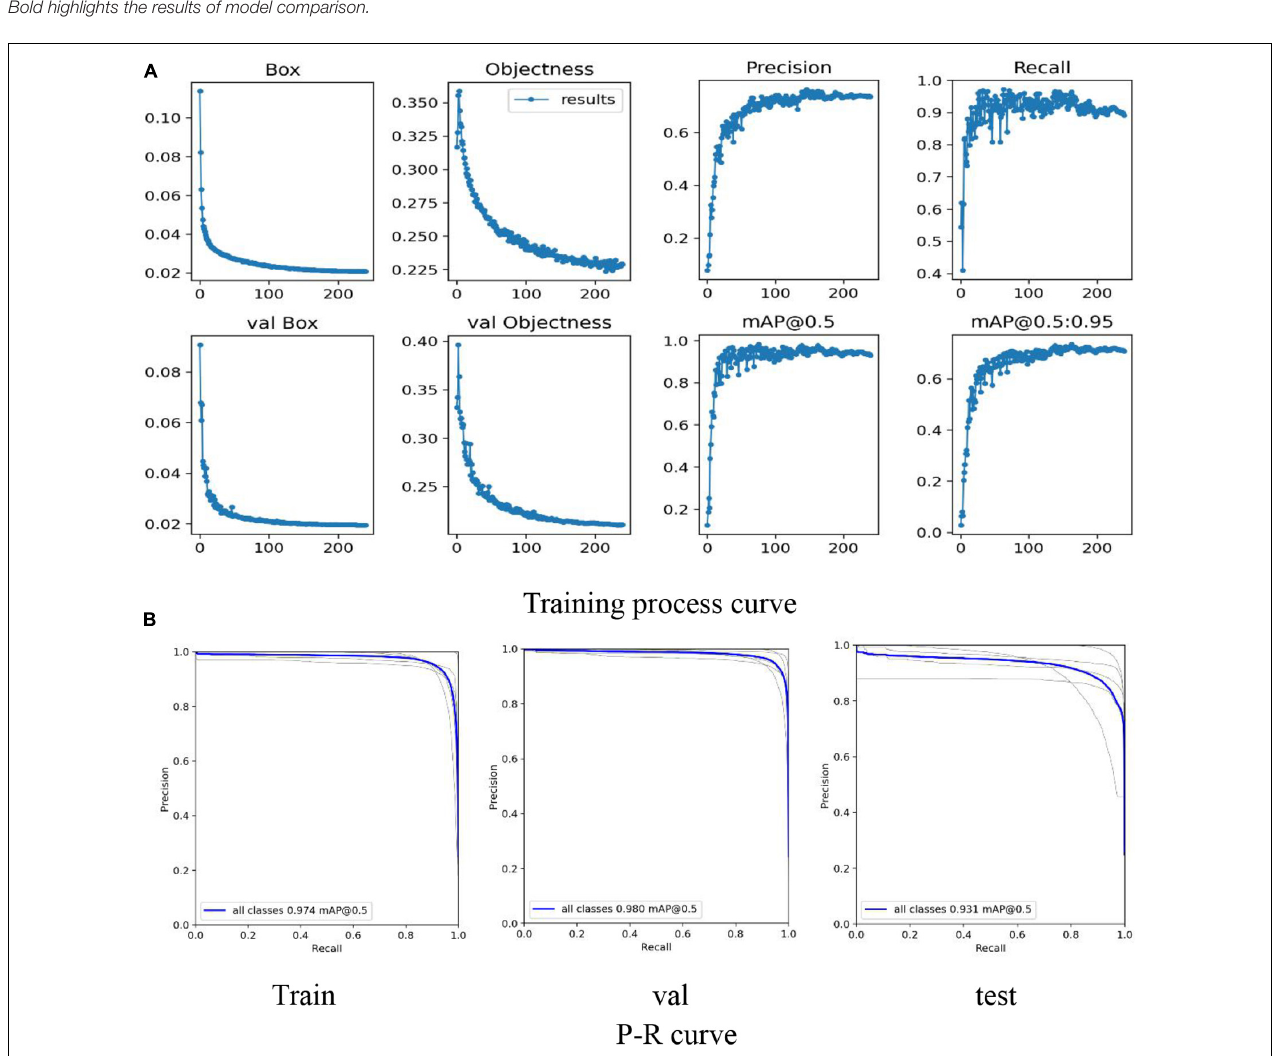
FIGURE 8 | Classification model training process based on YOLO-V5. (A) Mainly reflects the Loss, Precision, Recall, mAP curves in the training process and the Loss curve in the verification process. (B) Mainly reflects the P-R curve of training, testing and verification to judge the pros and cons of the